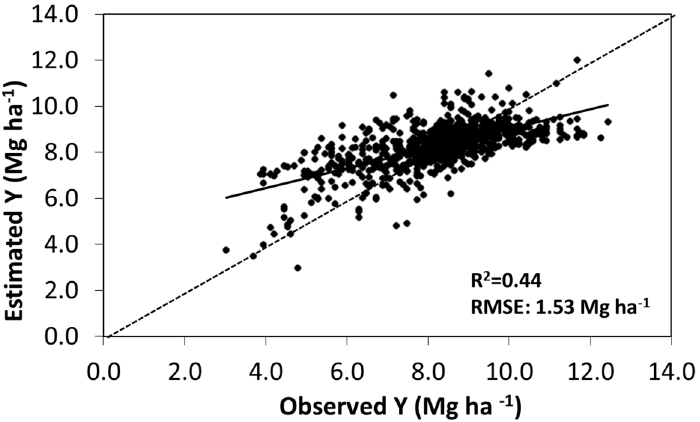
Figure 5. Estimated corn yield (Y) predicted with global meta-function via SPL method (Table 5 versus observed Y (end-season yield monitor data). Coefficient of determination (R 2 ) and root mean-square error (RMSE) was determined for the global regression. The dashed line portrays the 1:1 line for the estimated–observed yield relationship.